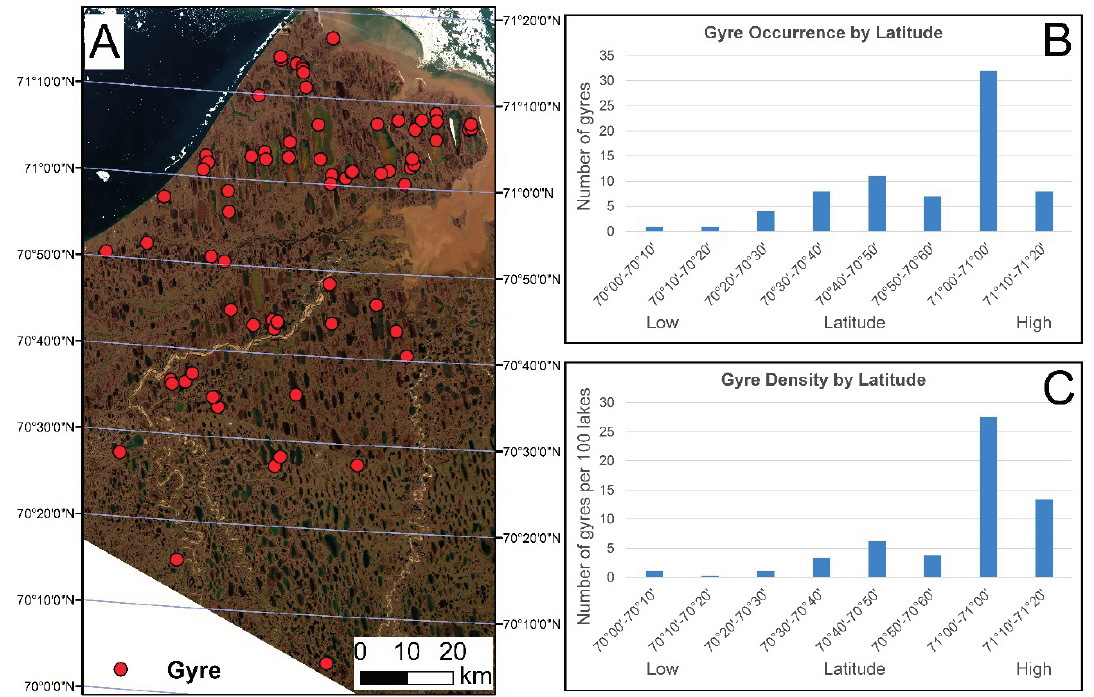
Figure 10. Occurrence of gyres in Barrow study area in one Landsat 8 scene on 10 July 2013 ( A ), the histogram of gyre numbers by latitude bins ( B ) and histogram of gyre density by latitude bins ( C ).